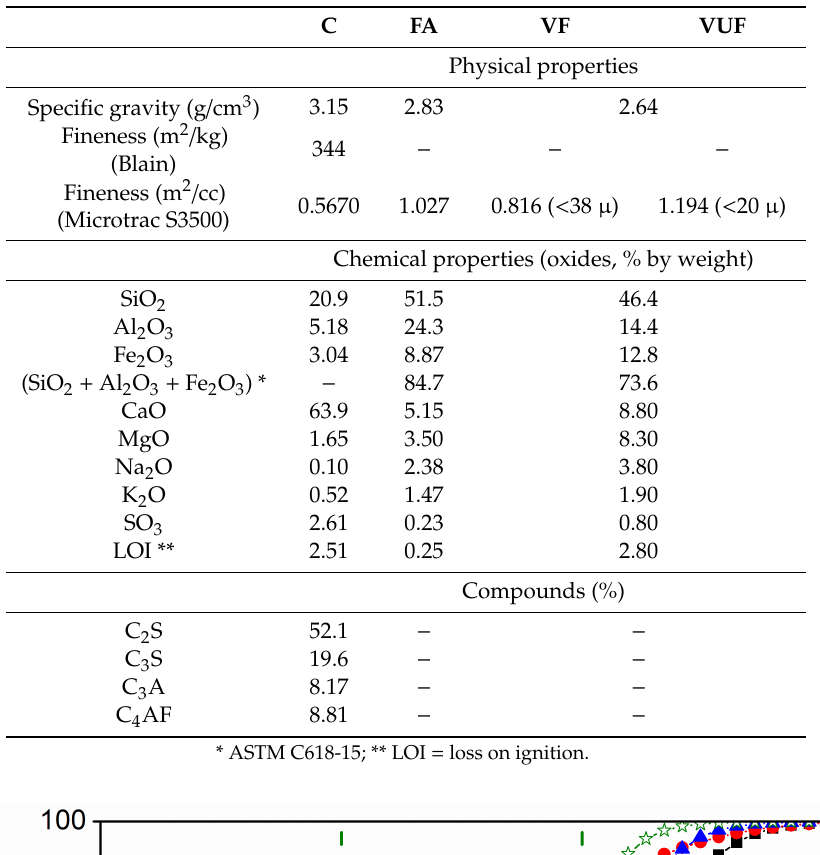
Table 1. Physical and chemical composition of cement, fly ash and basaltic volcanic ash.